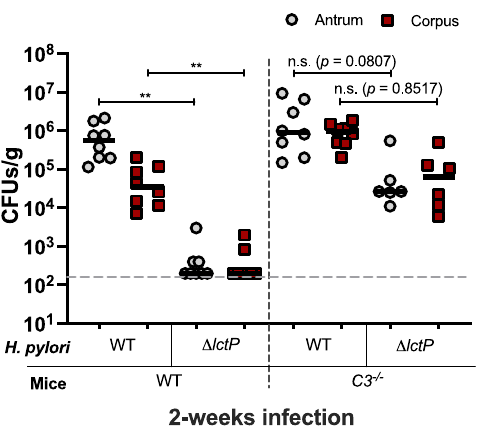
weaning for at least 4-weeks before the infection and remained cohoused for the whole experimental period. At the indicated time points, the stomachs were col- lected and bacterial CFUs were determined by plating. Each point represents one mouse sample, with black bars representing the mean. Gray dotted line represents thelimitofdetection.The p valueswereobtainedbyTukey ’ smultiplecomparisons test. The signi fi cance was indicated as * ( p <0.05), ** ( p <0.01), and n.s. (no sig- ni fi cance). Source data and exact p values are provided in the Source Data fi